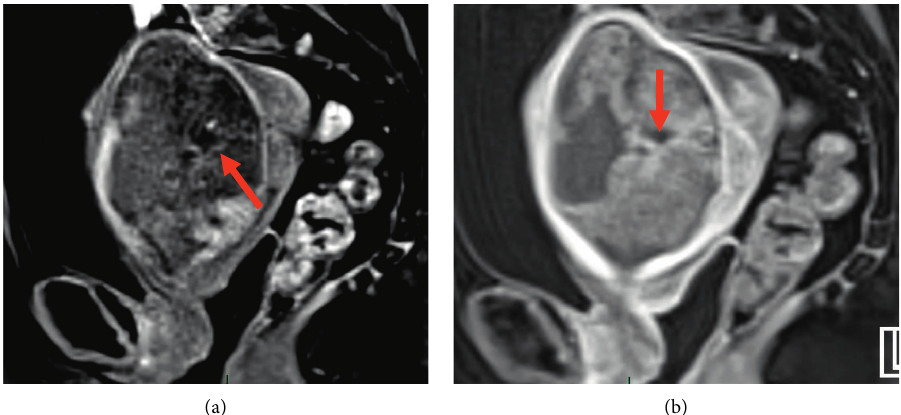
Figure 6: Pelvic MRI of MMMT: (a, b) sagittal DCE-MRI evaluated the presence of tumoral vessels in the lesion at arterial phase (arrow) (a) and percentage of necrosis at venous phase (arrow)